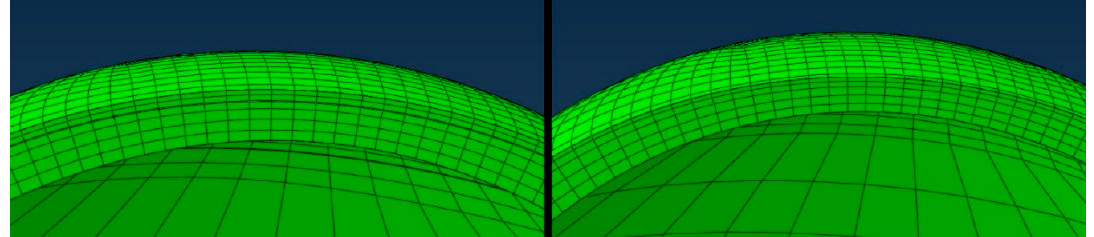
Figure 1. A representative mesh of preoperative corneal models for LASIK (left frame) and PRK (right frame). Both models consist of an anterior epithelial layer and underlying stromal layers. Sublayers, defined from anterior to posterior, for LASIK ( left ) are the epithelium, stromal component of the flap, flap interface wound (bolded boundary), and residual stromal bed. Sublayers for PRK ( right ) are the epithelium and residual stromal bed ( right ).